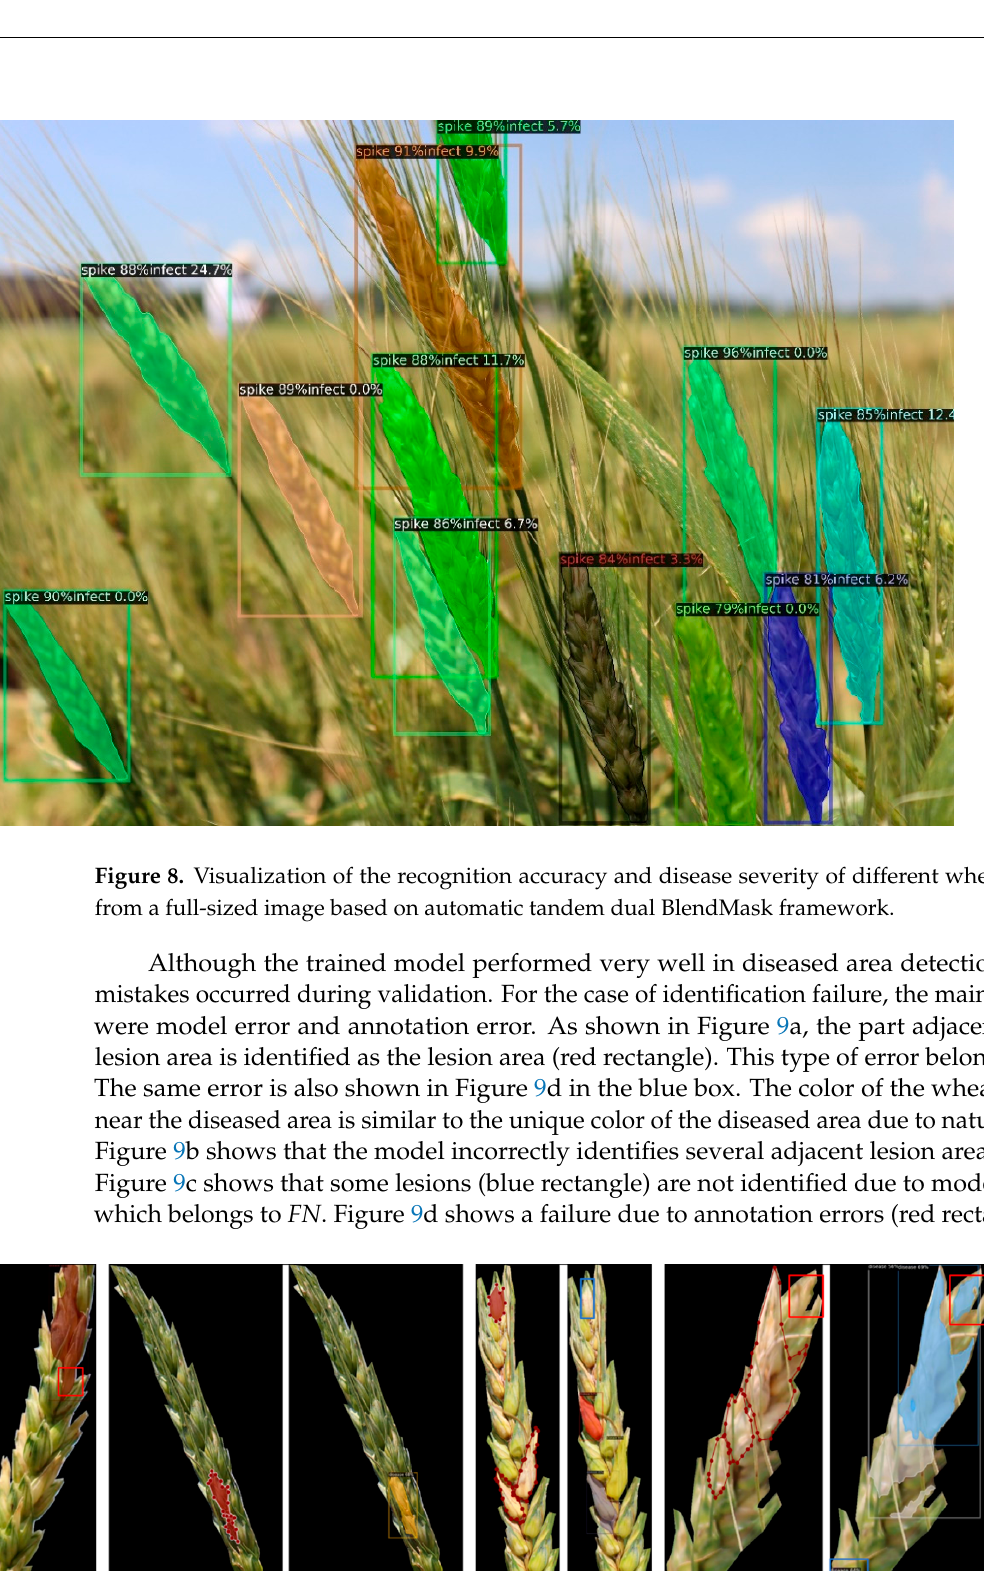
Figure 7. A flowchart of the combination of dual BlendMask models for evaluating FHB disease severity.